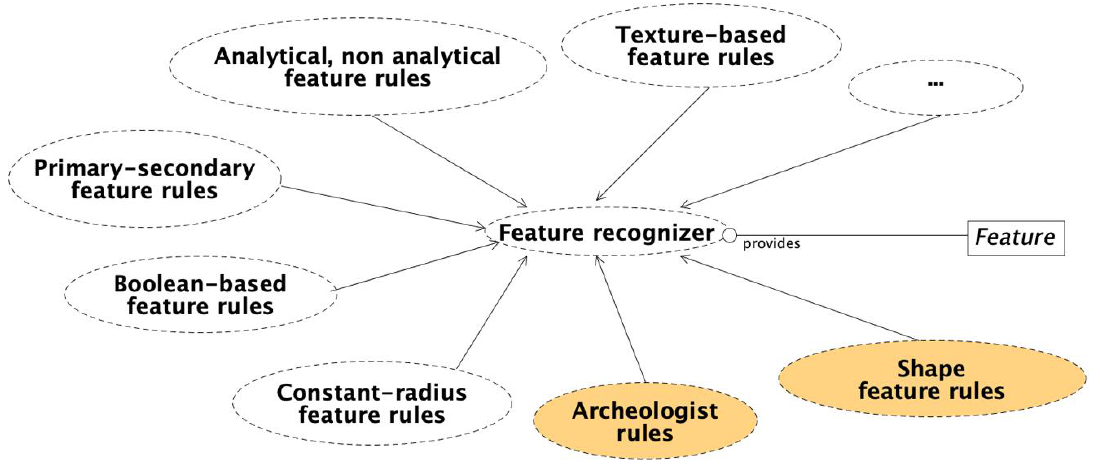
Figure 2. Feature recognizer service.